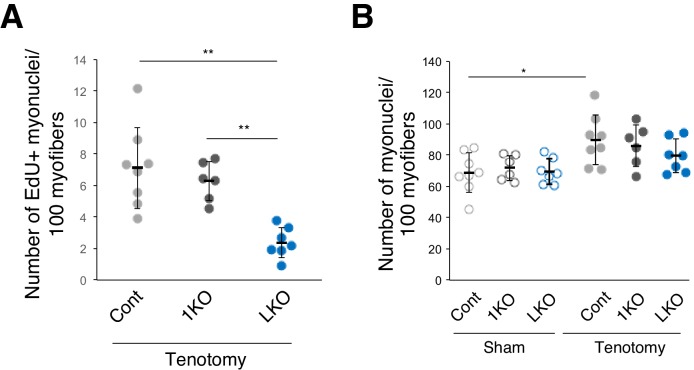
Number of EdU+ or total myonuclei per 100 myofibers.(A) The number of EdU+ myonuclei per 100 myofibers at 1 week after tenotomy (Cont: light gray, n = 8; 1KO: black, n = 6; LKO: blue, n = 7). The number of EdU+ located beneath dystrophin staining was counted. **p<0.01. (B) The number of total myonuclei per 100 myofibers from sham (open circle) or 1 week after tenotomy (closed circle) (Cont: light gray, n = 8; 1KO: black, n = 6; LKO: blue, n = 7). The number of nuclei (DAPI) located beneath dystrophin staining was counted. *p<0.05.10.7554/eLife.48284.019Figure 5—figure supplement 1—source data 1.Numerical data for making the graphs in Figure 5—figure supplement 1.Experiment number corresponds to all results.